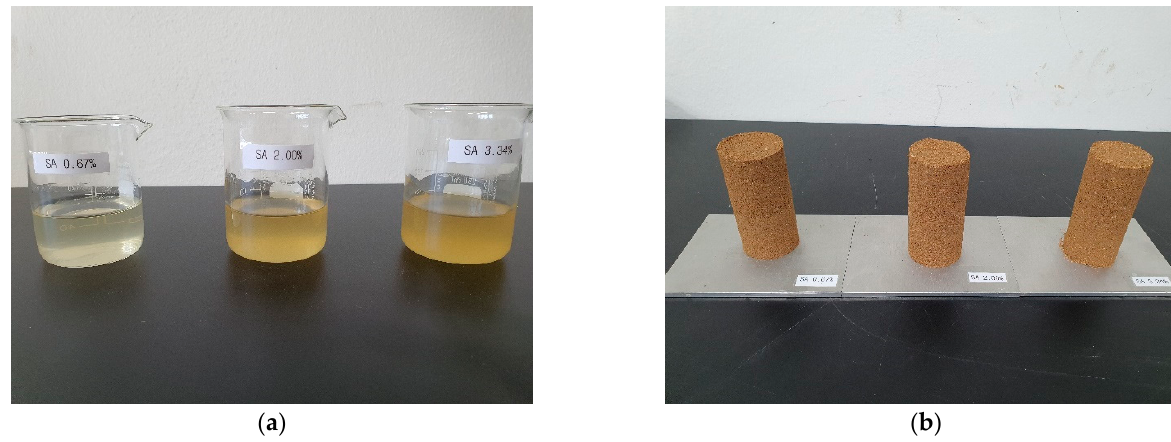
Figure 5. ( a ) Sodium alginate (SA) solutions; ( b ) Specimens after mixture with SA solutions.